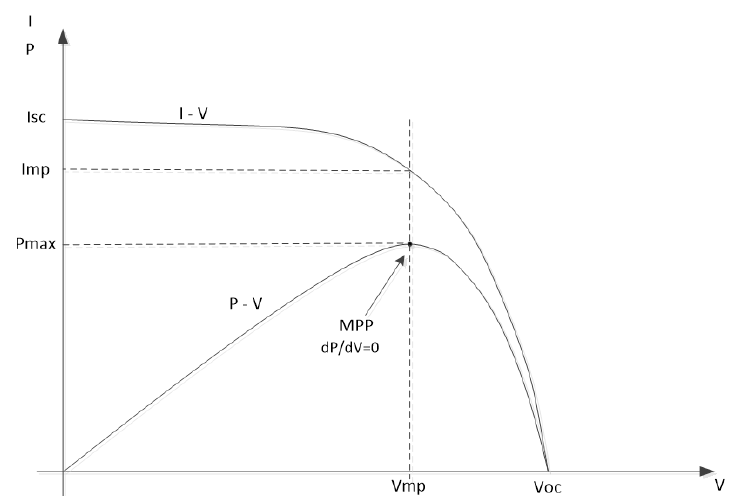
Figure 1. Modular power supply